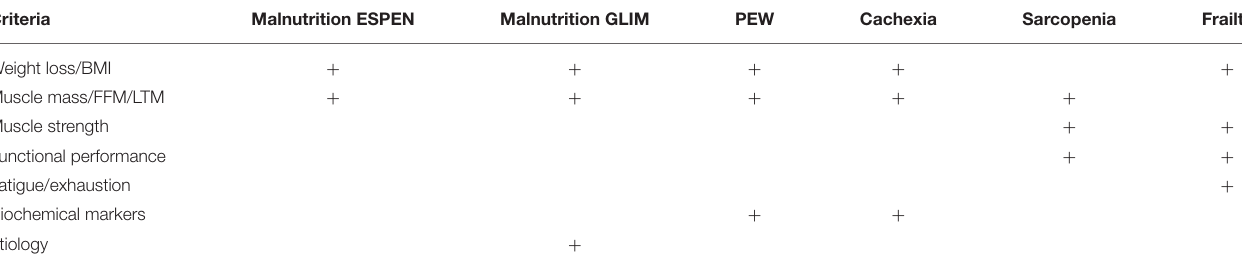
TABLE 1 | Categories of assessment for the diagnosis of different syndromes related to the nutritional and functional status of patients. Criteria Malnutrition ESPEN PEW Cachexia